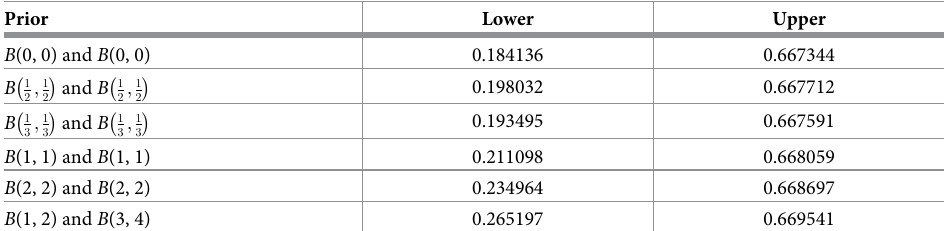
Table 4. 95% equal-tailed credible intervals for the Black Death plague data from Table 2 for various priors. Prior Lower Upper B (0, 0) and B (0, 0) 0.184136 0.667344